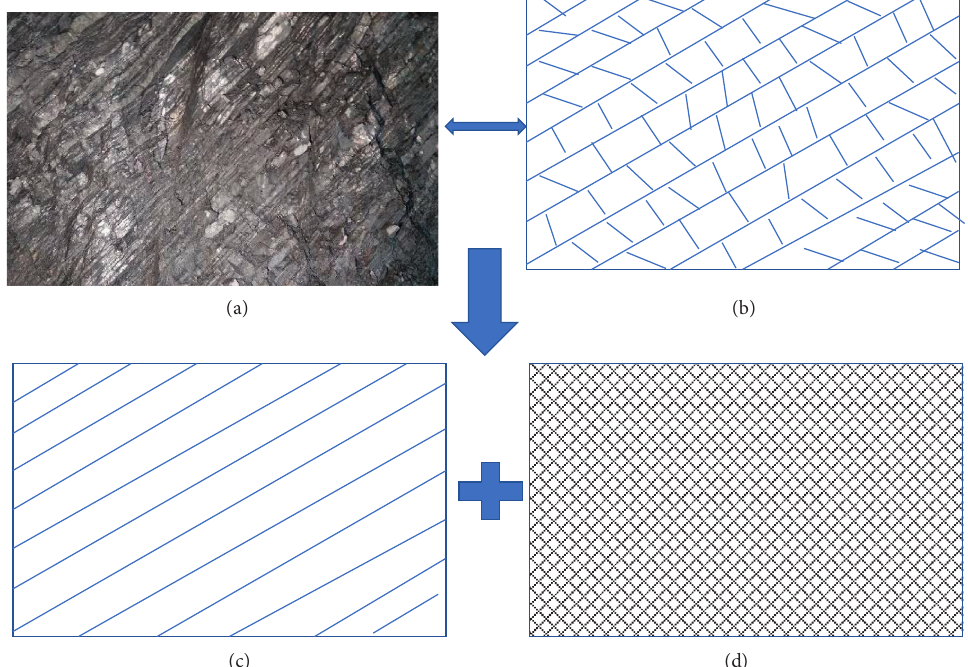
Figure 6: Modelling method of equivalent joints with dominant joints: (a) photo of the tunnel face, (b) generalization of the joint distribution, (c) dominant joints, and (d) equivalent